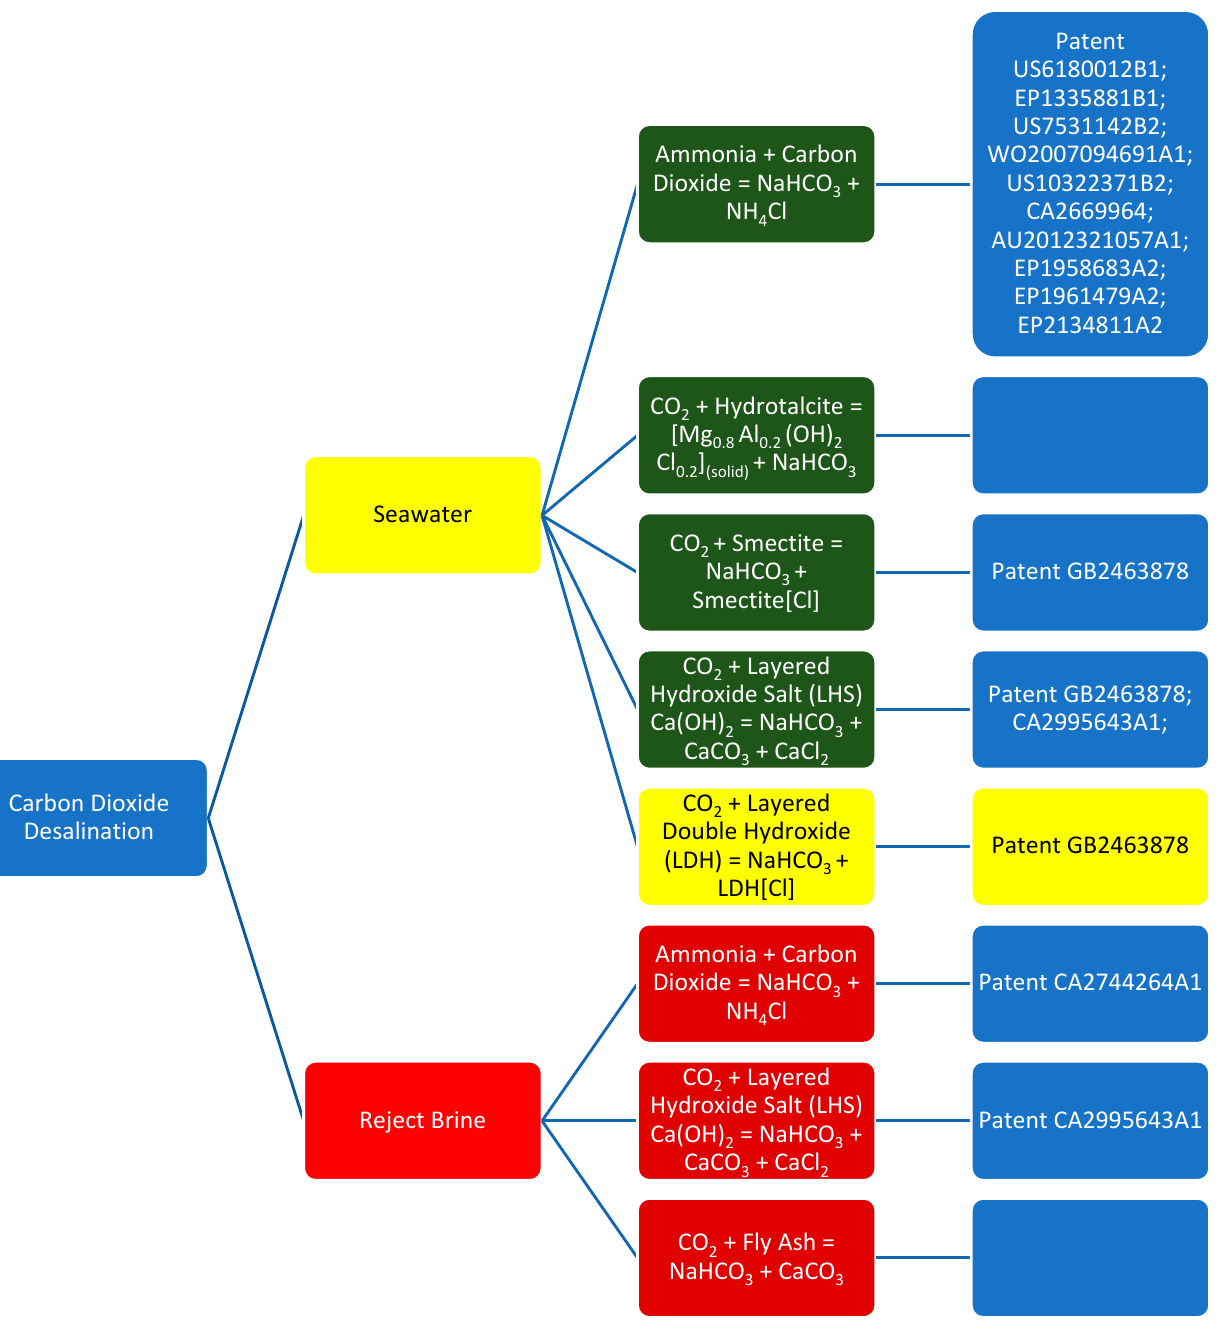
Figure A2. Carbon dioxide desalination approach and associated patents and publications. The trial results recorded in this study may have had some of the NaCl removed by CO 2 –LDH desalination. Academic References: (i) CO 2 + Hydrotalcite = [Mg 0.8 Al 0.2 (OH) 2 Cl 0.2 ] (solid) + NaHCO 3 : [38]; (ii) CO 2 + Hydrotalcite = [Mg 0.8 Al 0.2 (OH) 2 Cl 0.2 ] (solid) + NaHCO 3 : [39–42]; (iii) CO 2 + Layered Hydroxide Salt (LHS) Ca(OH) 2 = NaHCO 3 + CaCO 3 + CaCl 2 : [43]; (iv) CO 2 + Fly Ash = NaHCO 3 + CaCO 3 : [44].